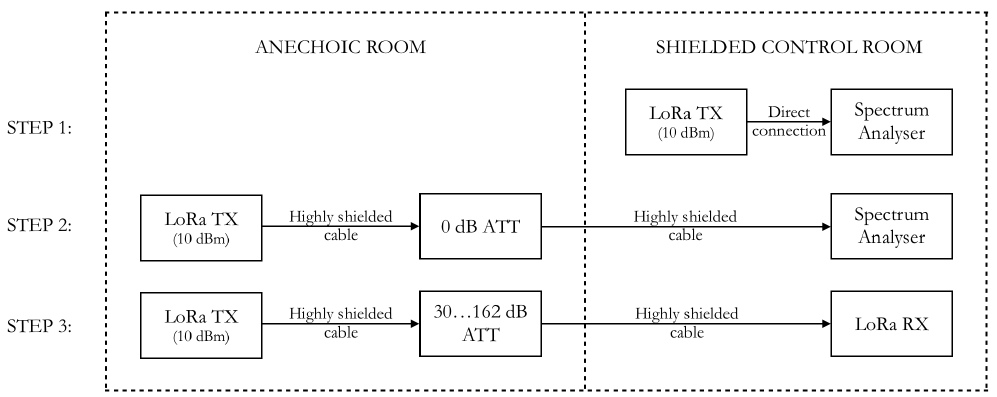
Figure 2. Calibration